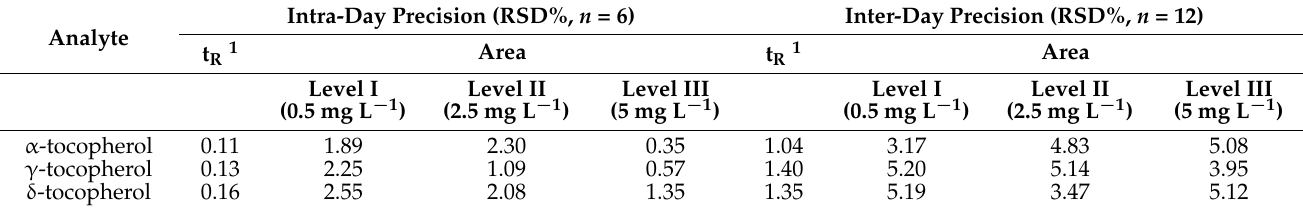
Table 2. Precision parameters (expressed as relative standard deviation (RSD%)) obtained analyzing the standards mixture in optimized